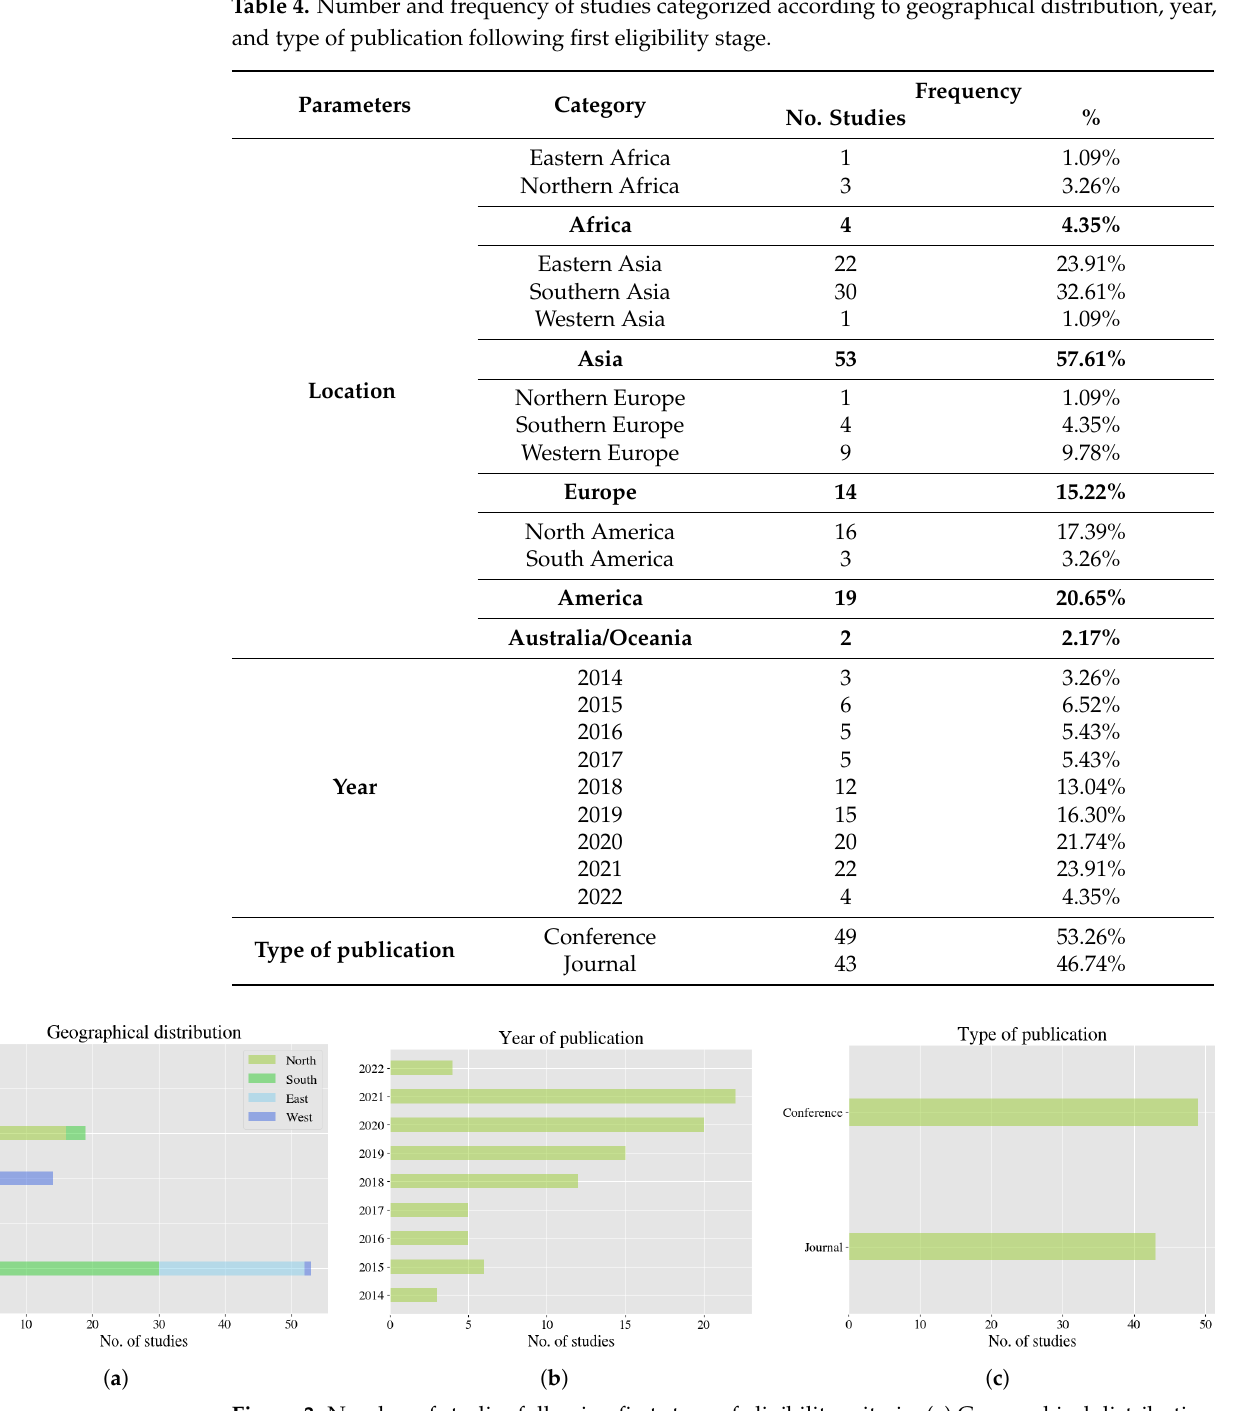
Figure 3. Number of studies following first stage of eligibility criteria. ( a ) Geographical distribution. ( b ) Year of publication. ( c ) Type of